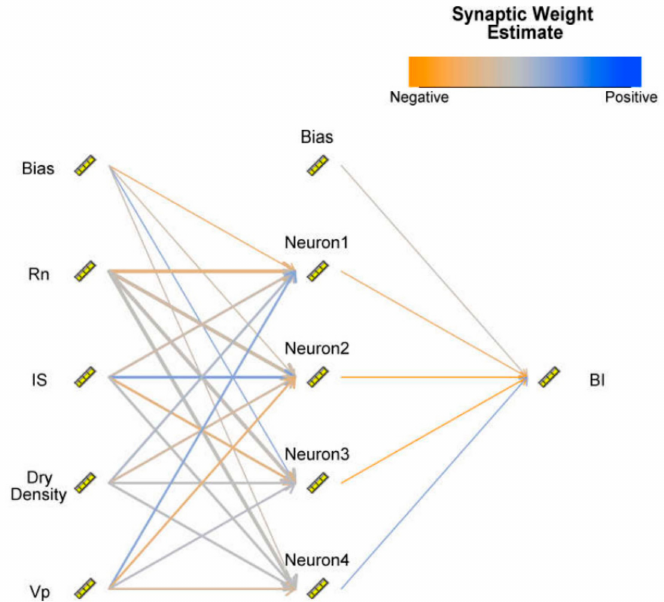
Figure 8. ANN network for predicting the BI .